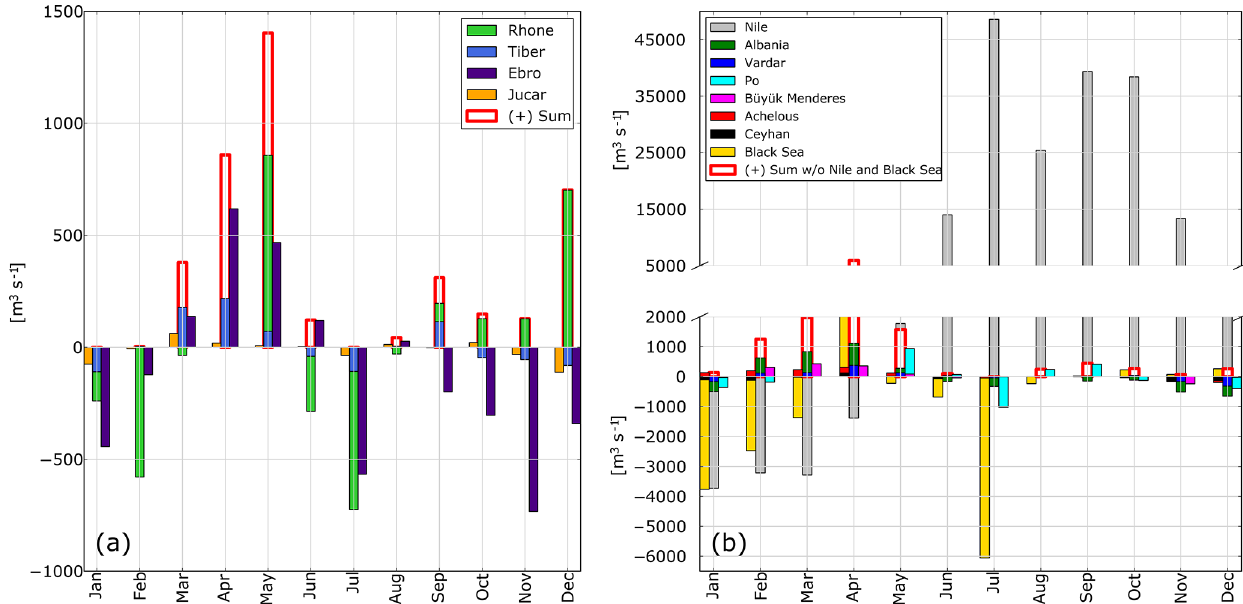
Figure 11. Monthly anomalies (EHOL–PICTRL, with seasonal variation) of freshwater discharges (m 3 s − 1 ) for major rivers flowing into the western basin (a) and the eastern basin (b) . The sum of all rivers for each basin is also plotted. The Nile and the Black Sea are also shown as rivers of the eastern basin but not accounted into the basin-scale sum.